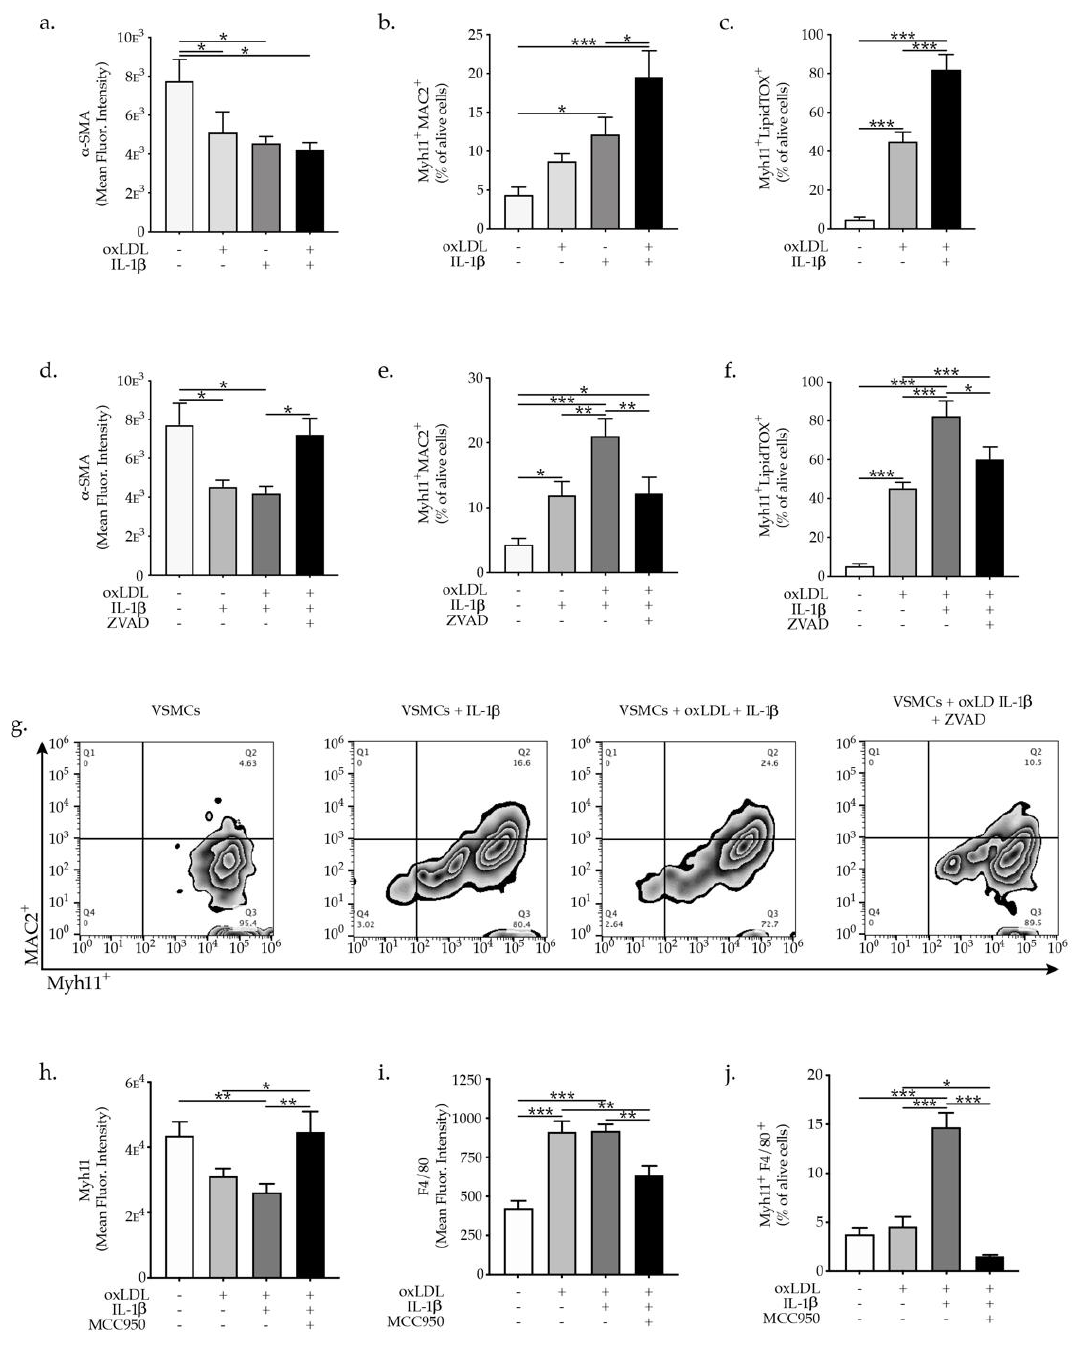
Figure 5. Graph bars represent the mean ± SEM of ( a ) α -SMA + , ( b ) Myh11 + MAC2 + expression and ( c ) Myh11 + LipidTOX + (foam cells) formation of VSMCs upon oxLDL and IL- β treatment as indicated, with n = 6/group and * p < 0.05, ** p < 0.01, *** p < 0.001. Graph bars represent the mean ± SEM of ( d ) α -SMA + , ( e ) Myh11 + MAC2 + , expressed as mean fluorescence intensity and ( f ) Myh11 + LipidTOX + (foam cells) expressed as a percentage of a alive VSMC upon oxLDL and/or IL- β and/or ZVAD treatment as indicated, with n = 6/group and * p < 0.05, ** p < 0.01, *** p < 0.001, one-way ANOVA. ( g ) Representative flow cytometry zebra plots of Myh11 + MAC2 + cells. Graph bars represent the mean ± SEM of ( h ) Myh11 + , ( i ) F4/80 + expressed as mean fluorescence intensity and ( j ) Myh11 + F4/80 + as a percentage of alive VSMC upon oxLDL and/or IL-β and/or MCC950 treatment as indicated, with n = 6/group and * p < 0.05, ** p < 0.01, *** p < 0.001, one-way ANOVA.